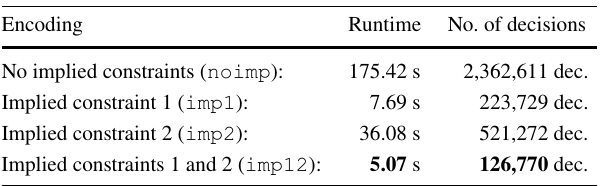
Table 3 Runtime and number of decisions required to solve the